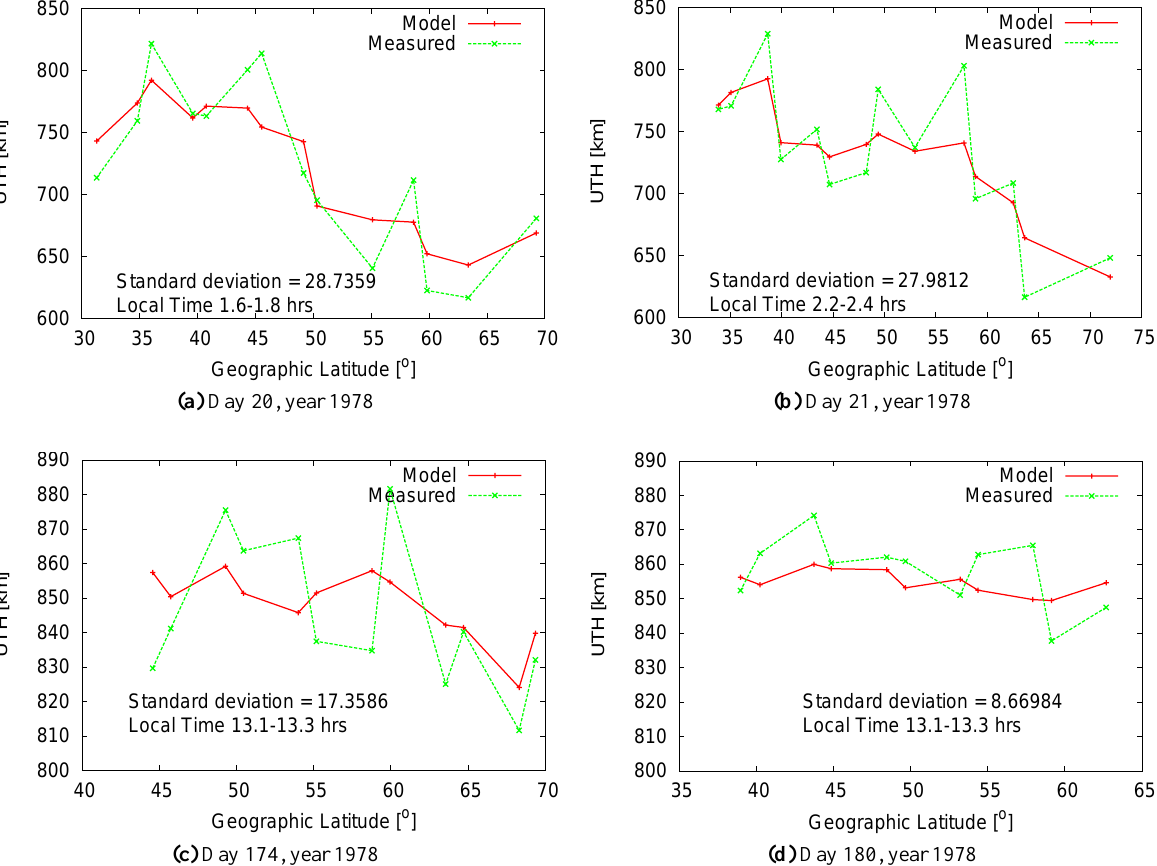
Fig. 3. Comparison between model and measured values for four snapshot measurements taken on the days indicated on each sub-caption. On the x-axis is the geographic l atitude for the measurements. Indicated on each plot is the local time range over which the measurements were made as the satellite passed over the region indicated by the latitude